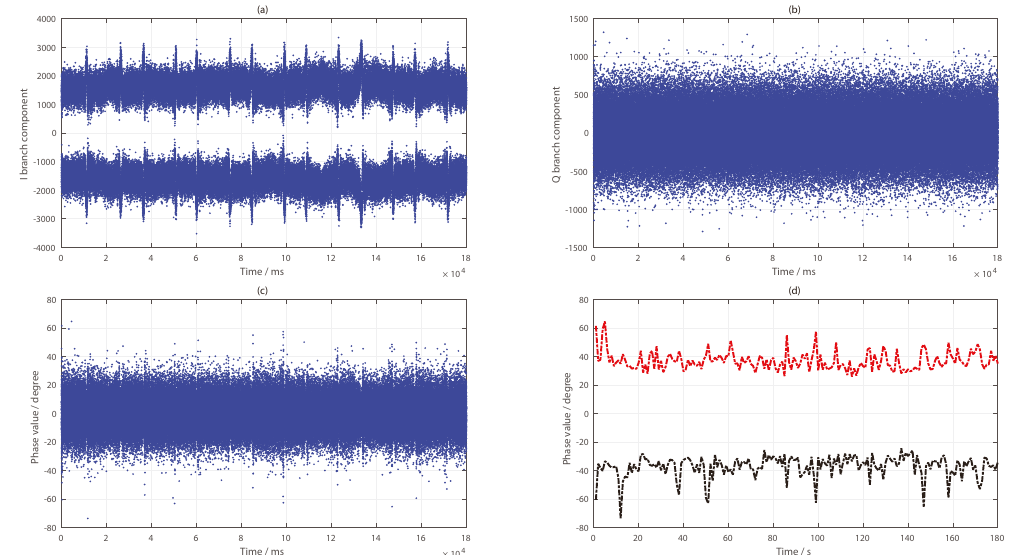
Figure 20. Results of the BeiDou PRN23 satellite reflected signal: ( a ) I branch component data; ( b ) Q branch component data; ( c ) phase difference information (in ms); ( d ). phase difference information (in